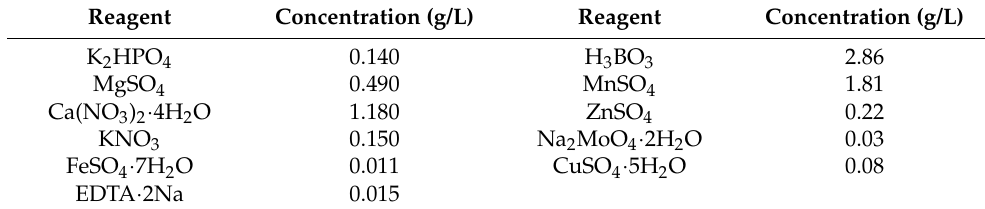
Table 1. Modified Hoagland nutrient solution